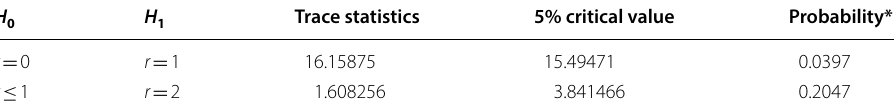
a Optimum lag order selected by the criterion Table 5 Results of Johansen cointegration test (trace statistics) for FDI and FT. Source: Calculated by